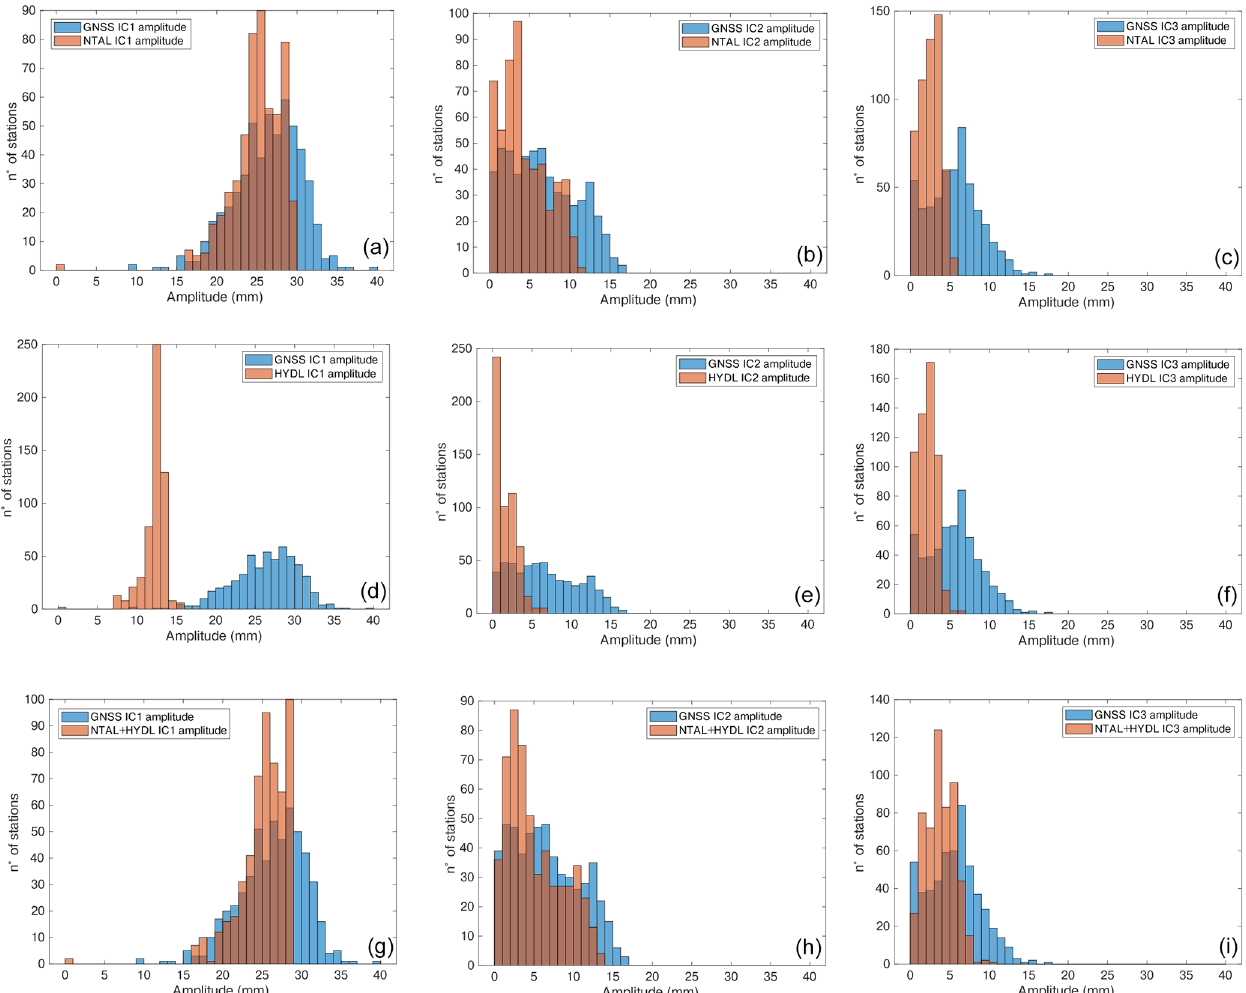
Figure 6. Histogram of the maximum displacements associated with (a) IC1 of the NTAL decomposition (orange) compared with the IC1 of the GNSS decomposition (blue). Panel (b) is the same as (a) but referring to IC2. Panel (c) is the same as (a) but referring to IC3. (d) IC1 of the HYDL decomposition (orange) compared with the IC1 of the GNSS decomposition (blue). Panel (e) is the same as (d) but referring to IC2. Panel (f) is the same as (d) but referring to IC3. (g) IC1 of the NTAL + HYDL decomposition (orange) compared with the IC1 of the GNSS decomposition (blue). Panel (h) is the same as (g) but referring to IC2. Panel (i) is the same as (g) but referring to